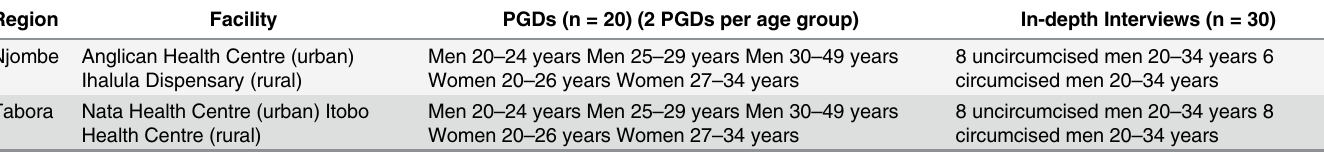
Table 1. Sample of Health Facilities and Interview and Group Discussion Participants. Region Facility